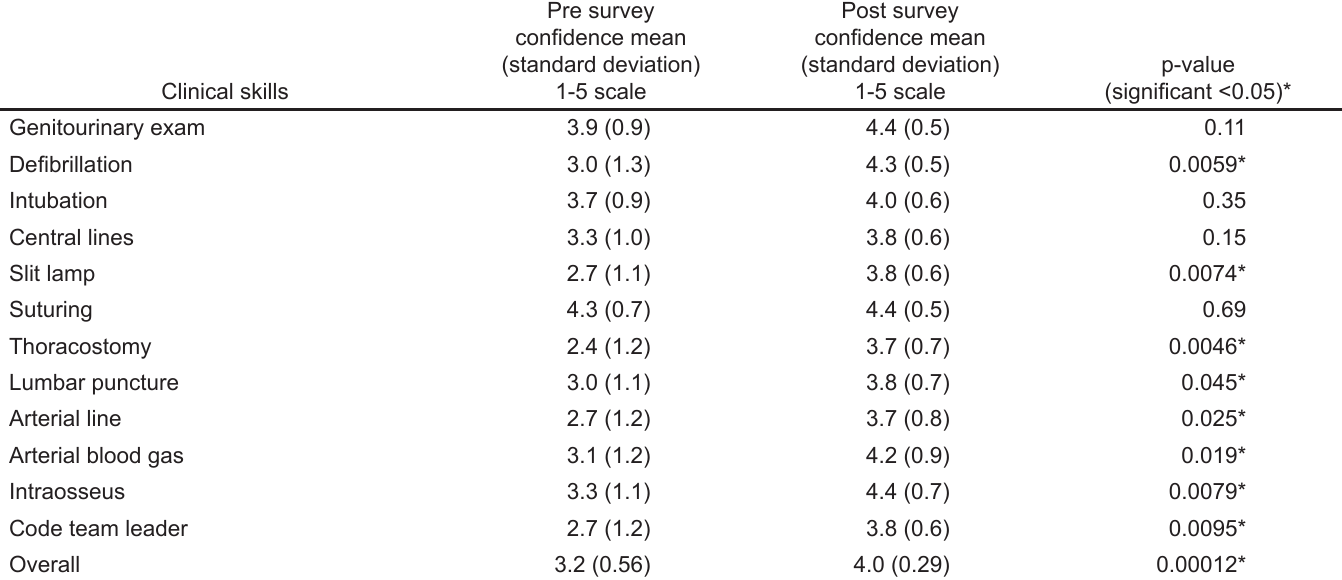
Table 1. Pre- and post-survey confidence scores of interns participating in an emergency medicine boot camp.